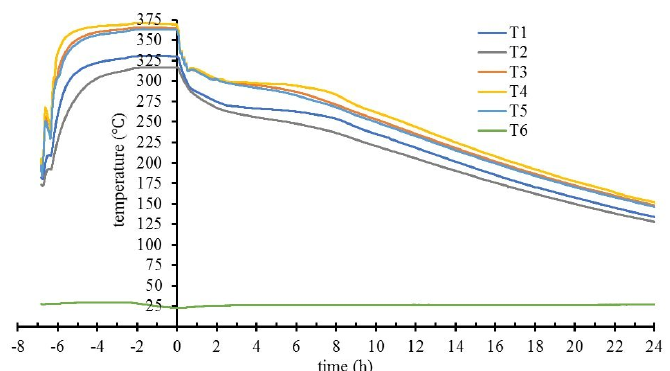
Figure 5. T1 to T6 temperatures readings (positions in the prototype tank indicated in Figure 1) during a heating–cooling cycle.